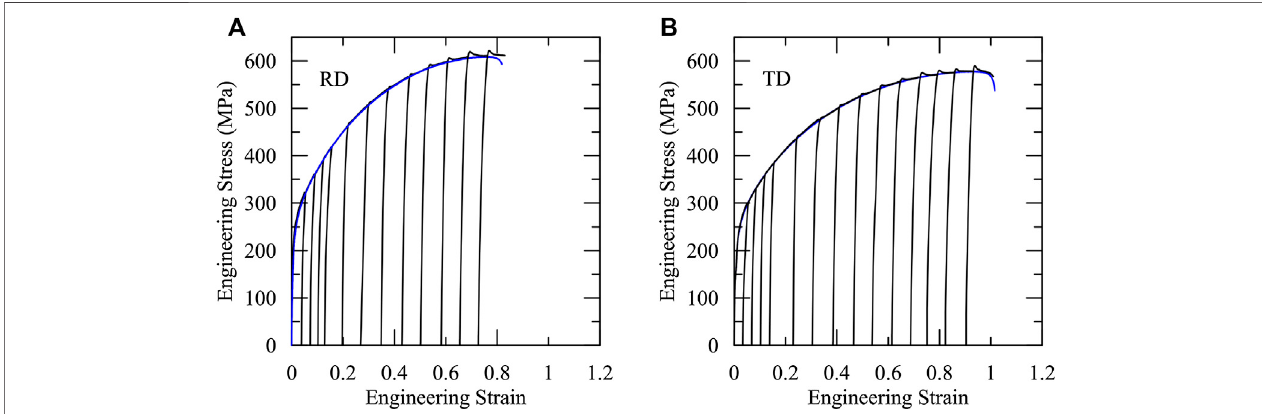
FIGURE 2 | Engineering stress vs engineering strain of a 304 stainless-steel in the (A) rolling direction and (B) transverse direction from monotonic and interrupted tests. Tests were performed at room temperature and a strain rate of 0.001 s − 1 . The interrupted tests were fully unloaded and held at room temperature prior to